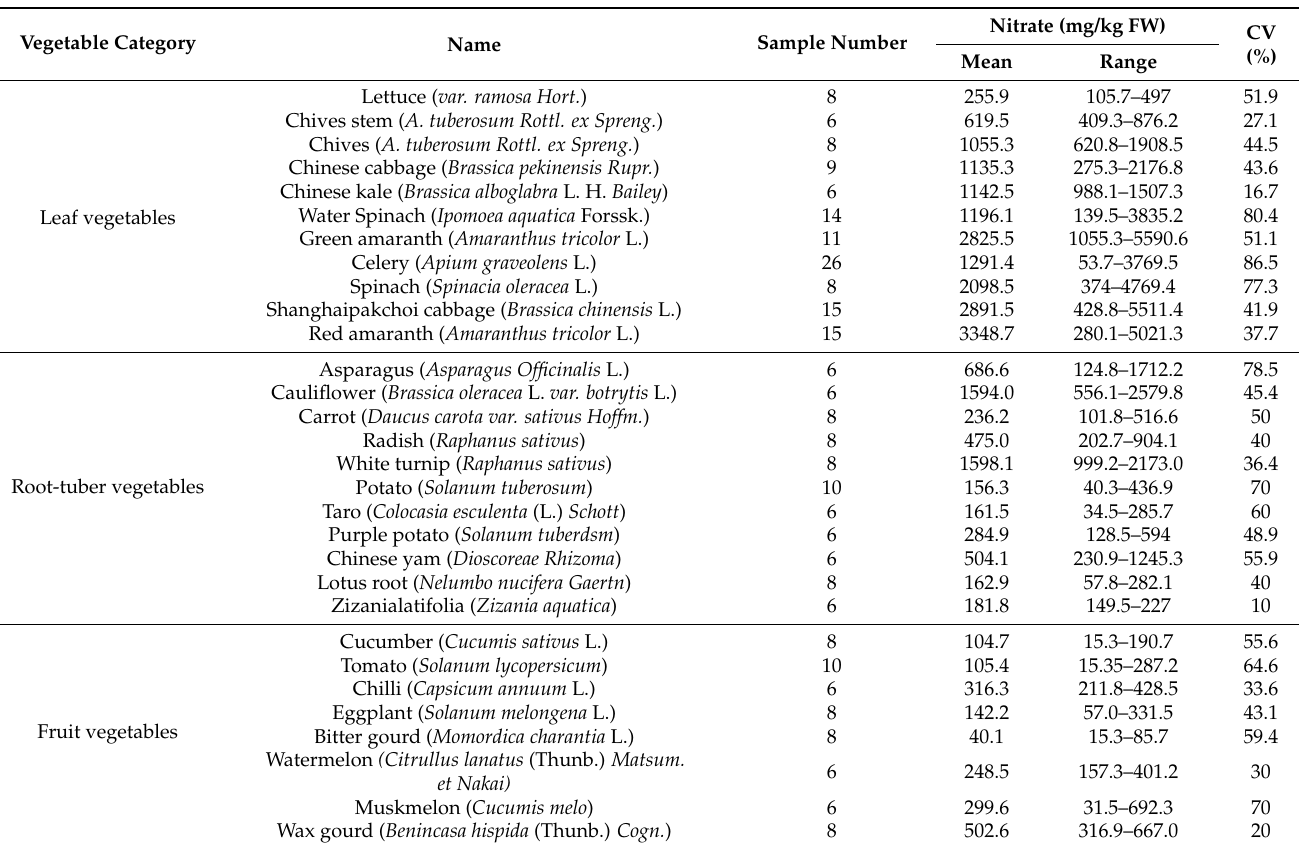
Table 4. Content of nitrate in the fresh vegetables collected in five farmers’ markets in Shanghai, Southeast